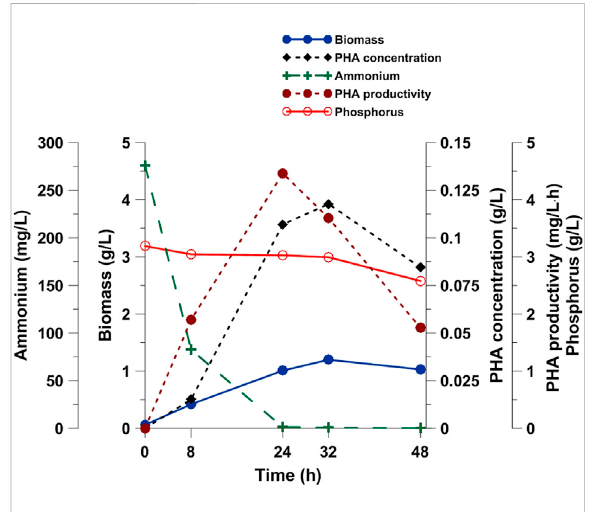
FIGURE 3 PHA production, cell, ammonium and phosphate concentration during Pseudomonas sp. GL06 cultivation on SMCFA extracted -rich stream in the bioreactor